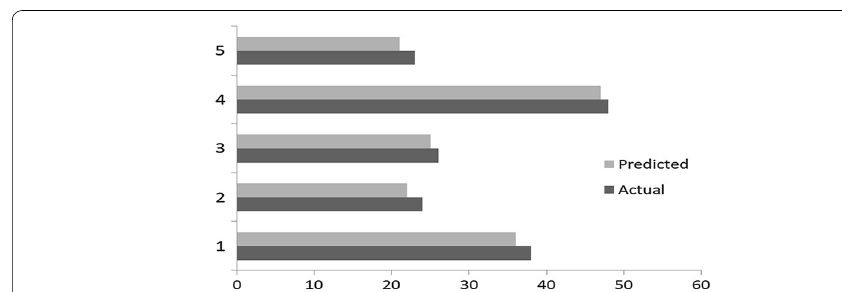
Fig. 5 Actual values of LSRP compared to predicted